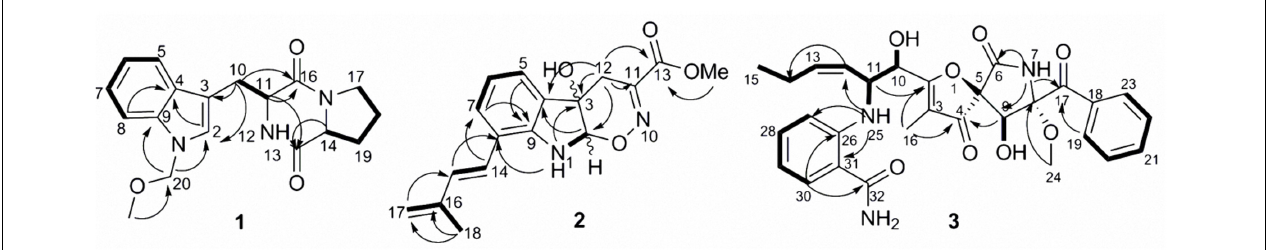
FIGURE 2 | Key COSY correlations in bold and HMBC correlations shown with arrows of compounds 1 – 3 .